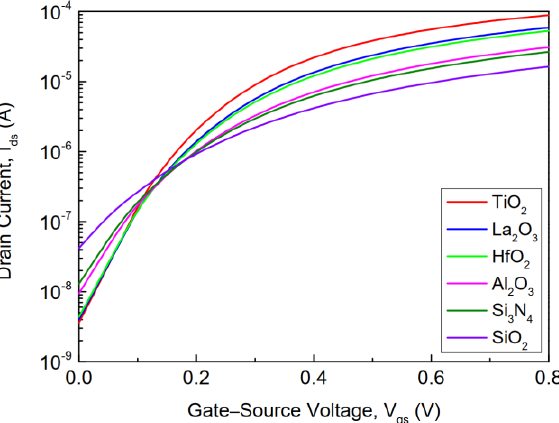
Figure 14. Transfer I – V characteristics in logarithmic scale for FinFET devices with different gate dielectric materials at V ds = 0.8 V.